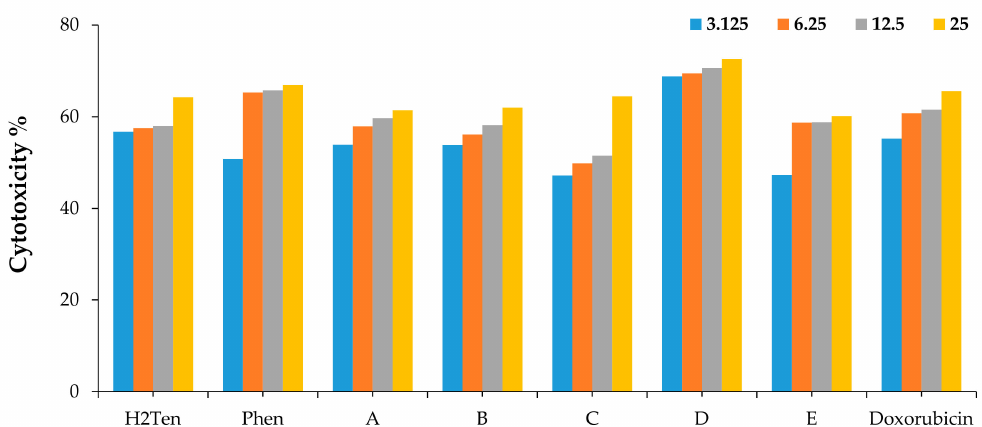
Figure 6. Dose dependent cytotoxic activities of H 2 Ten, Phen and their metal complexes against MCF-7 cancer cells according to the MTT assay. Where: 3.12, 6.25, 12.5, and 25.0 µ M are the concentrations, diluted in DMSO, used for the MTT assay.